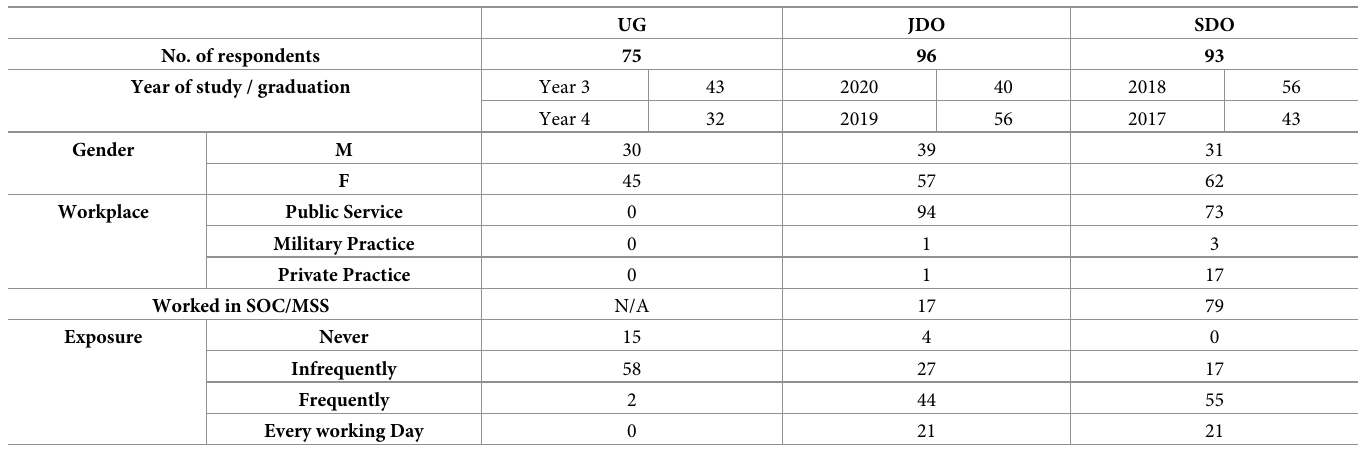
Table 1. Demographic profile of